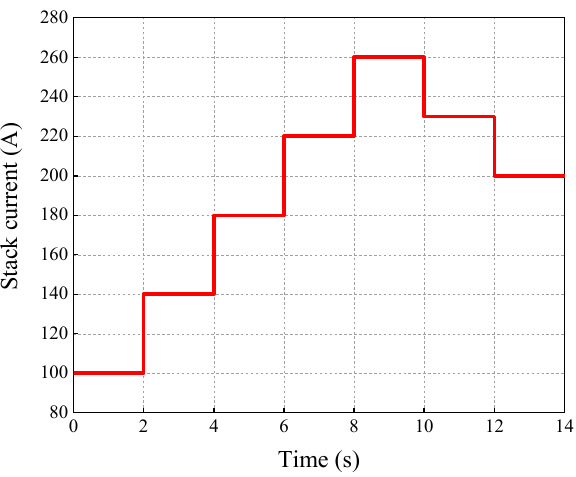
Figure 6. The step ‐ load current profile.